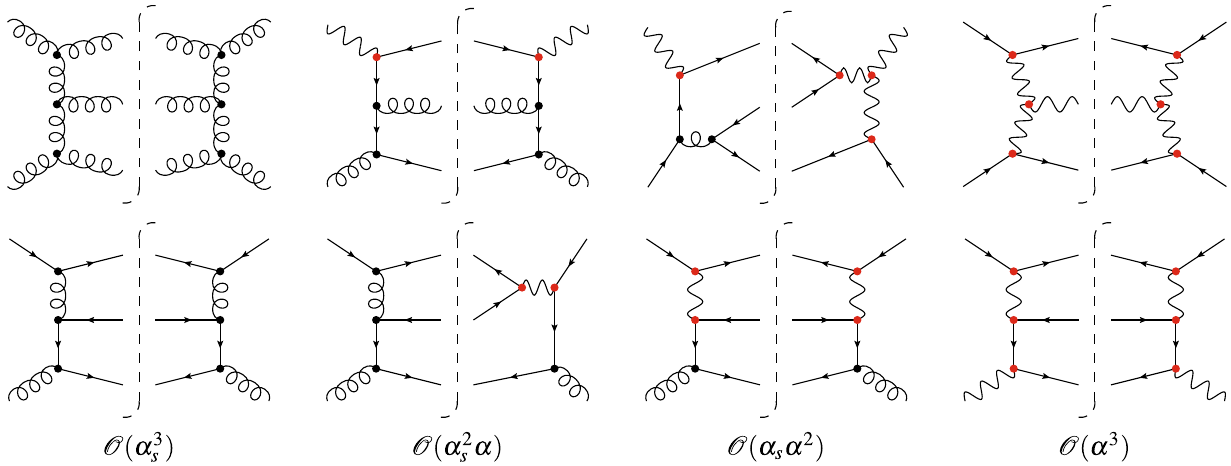
in the initial and final state are exemplified. While QCD vertices are marked by a black dot, EW interactions are indicated in red